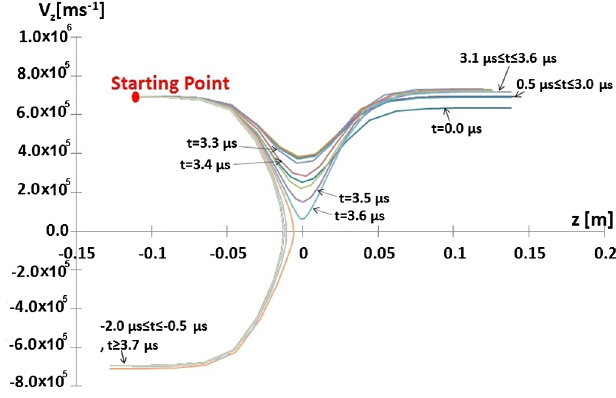
FIG. 38. Phase plot in z - v z space for particles injected into the Einzel lens at various